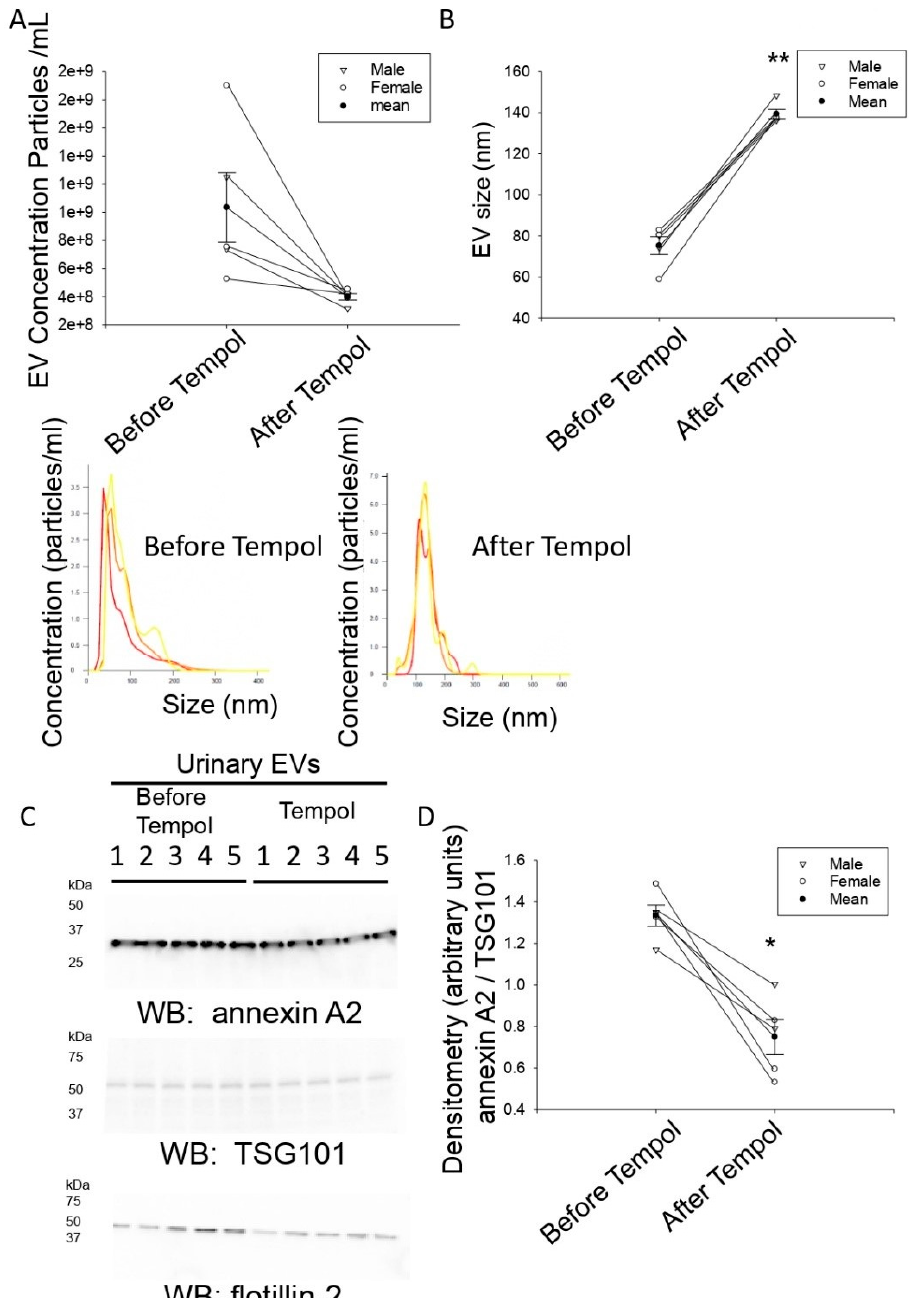
Figure 2. Characterization of urinary EV concentration and size. Urinary EVs were isolated from 24 h urine samples of salt-induced hypertensive 129Sv mice before and after Tempol infusion. Nanoparticle tracking analysis (NTA) was performed for each EV preparation in order to determine EV concentration and size. ( A ) Summary dot plot showing the concentration of urinary EV from each of the two groups. A paired t -test was performed and the p -value was 0.058. ( B ) Summary dot plot showing a difference in EV size between the two groups. A paired t -test was performed. Representative nanoparticle tracking images for each of the two groups is given below panel A and B. The three colors represent each sample being analyzed three times. ( C ) Western-blot analysis for Annexin A2, TSG101, and Flotillin-2 was performed to show enrichment of these EV markers in each of the EV preparations (N = 5) per group. ( D ) Densitometric analysis of the Annexin A2 immunoreactive band in panel C normalized to the TSG101 immunoreactive band. A paired t -test was performed. * Represents a p -value of < 0.05, ** represents a p -value of <